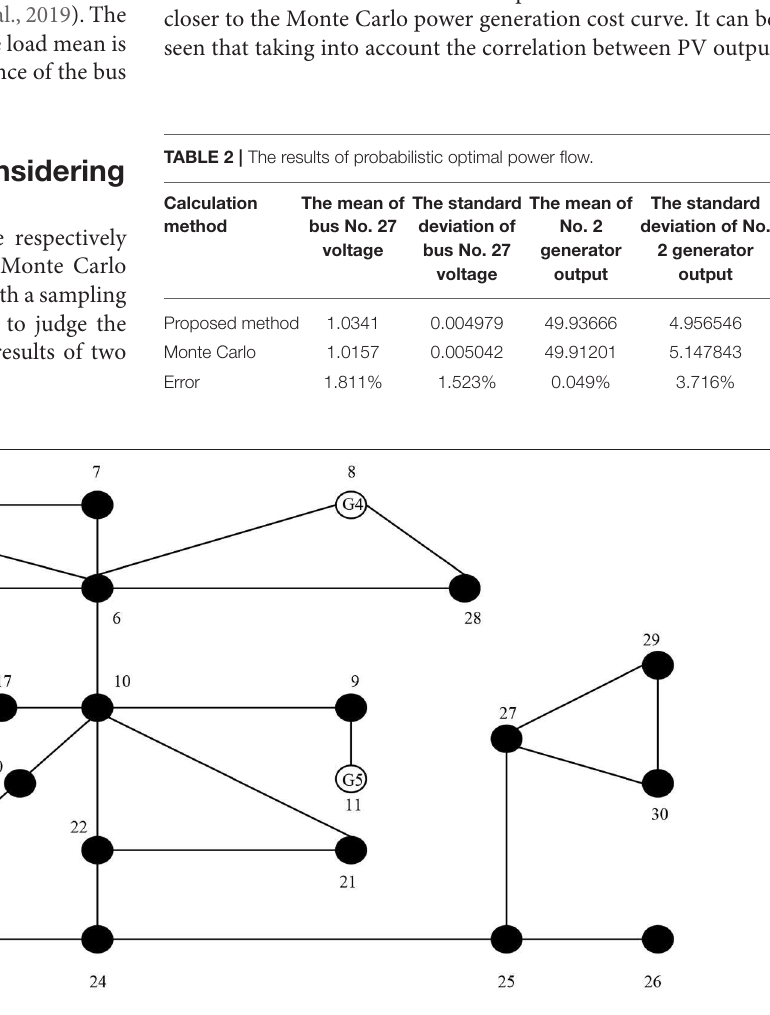
FIGURE 7 | The IEEE 30-bus power